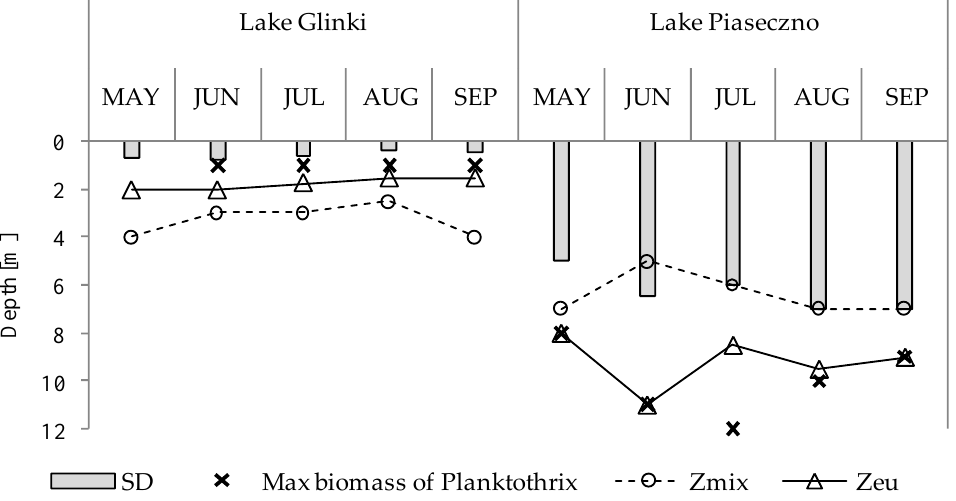
Figure 1. Variation in Secchi disk visibility (SD), the range of the euphotic zone (Zeu), the mixing zone (Zmix), and the depths with maximum Planktothrix agardhii and Planktothrix rubescens biomass during the vegetative season in Lake Glinki and in Lake Piaseczno, respectively.